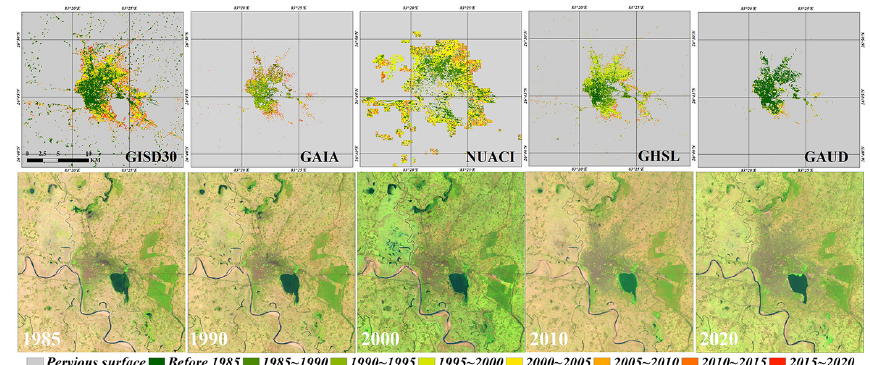
Figure 15. The comparisons between GISD30 and four reference datasets (the GAIA products developed by Gong et al., 2020; NUACI developed by Liu et al., 2018; GHSL developed by Florczyk et al., 2019; and GAUD developed by X. Liu et al., 2020) in the rural village. The multi-epoch Landsat imagery, comprised of SWIR1, NIR and red bands, came from the United States Geological Survey (https:// earthexplorer.usgs.gov/).